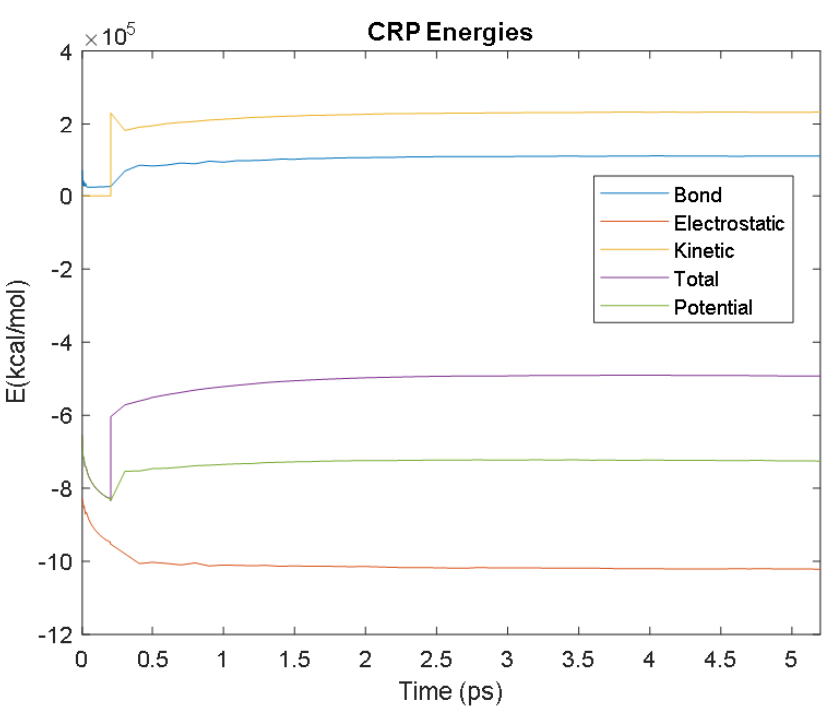
Figure 26. A plot of CRP’s bond, electrostatic, kinetic, total, and potential energies.